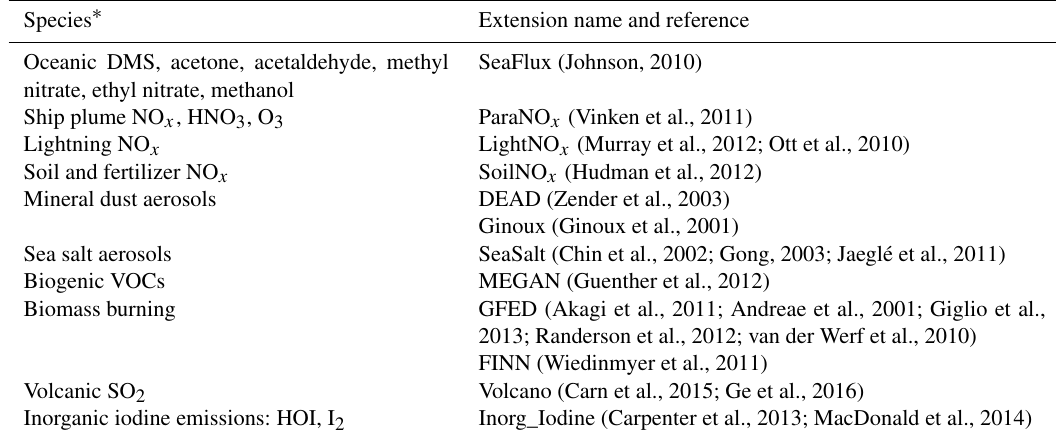
Table 2. Emission extensions available in HEMCO 3.0 as built-in algorithms. Species ∗ Extension name and reference Oceanic DMS, acetone, acetaldehyde,